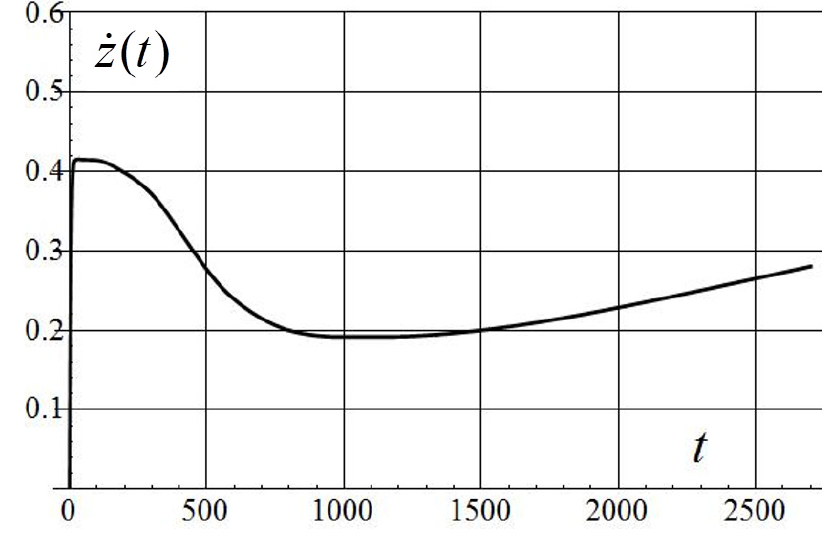
Figure 20. Speed of submersion versus time: equatorial waters, steel sphere, l ∗ = l s = 1/3, C D = 0.4, η =